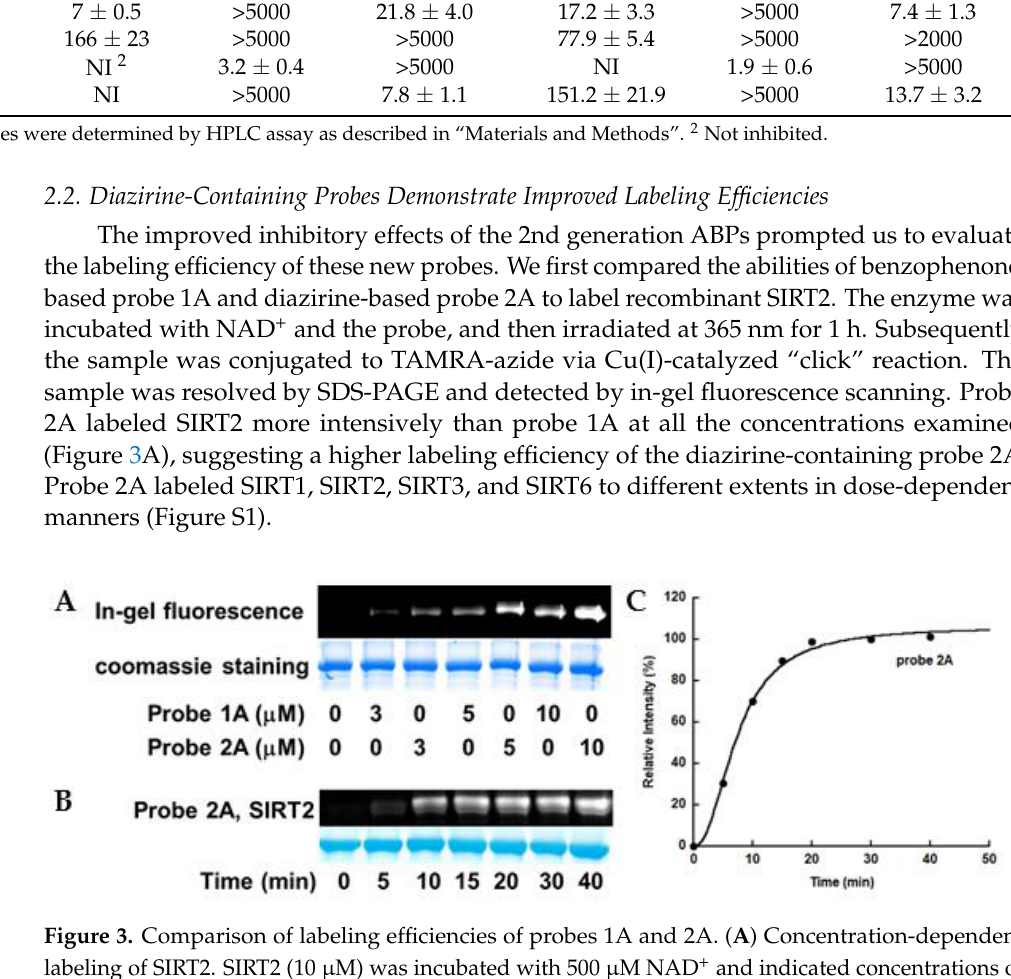
Table 1. IC 50 values of activity-based chemical probes (ABPs). 1